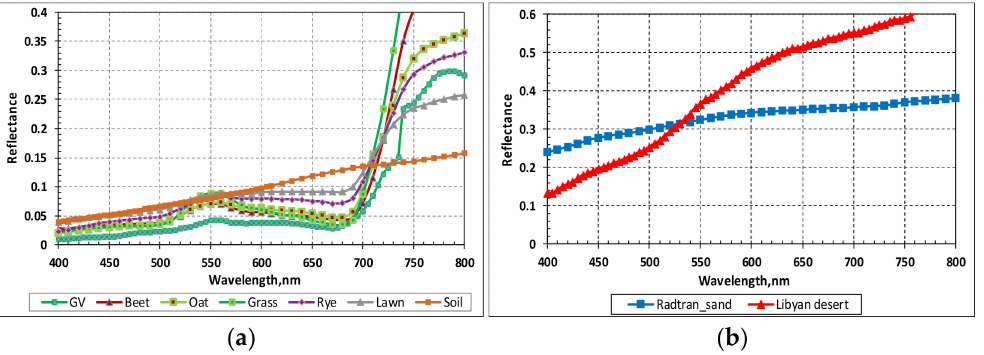
Figure 2. Spectral reflectance of certain types of vegetation ( a ) and of sand and desert ( b ).